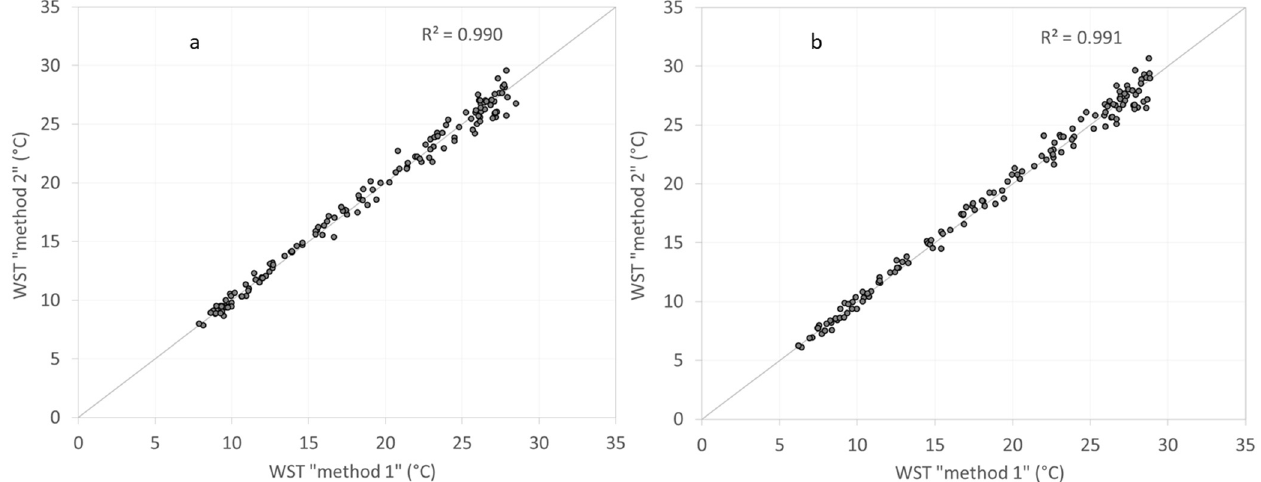
Figure 7. Water surface temperatures for Lake Bracciano ( a ) and Lake Martignano ( b ) derived from the same Landsat products acquired from 2000 to 2019 using the proposed standard algorithm (the “method 1” defined in Section 3.1) and the regression lines (the “method 2” defined in Section 3.2) for the atmospheric correction of the images.